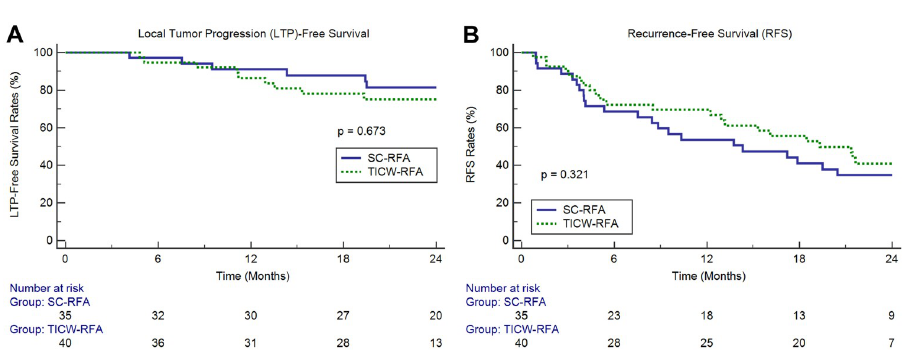
Fig 4. Comparison of clinical outcomes between TICW-RFA and SC-RFA groups. (A) LTP-free survival and (B) RFS in patients treated with TICW-RFA or